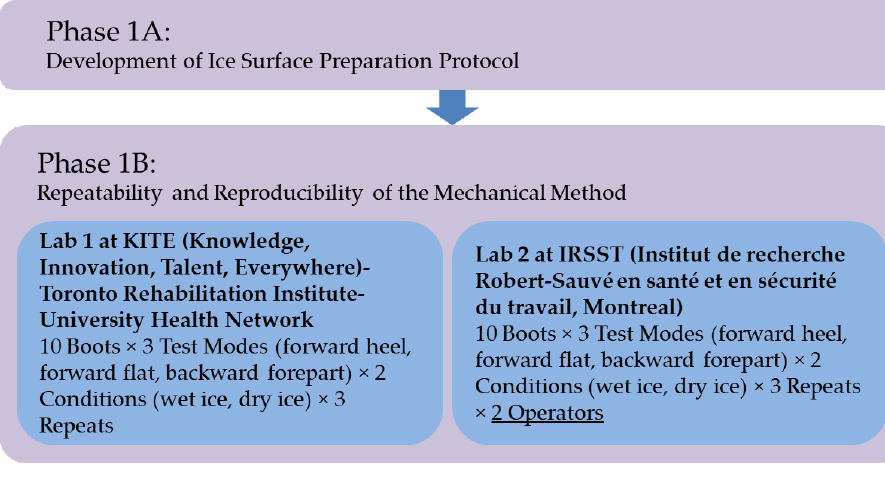
Figure 1. An overview of our testing process used in Phase 1.